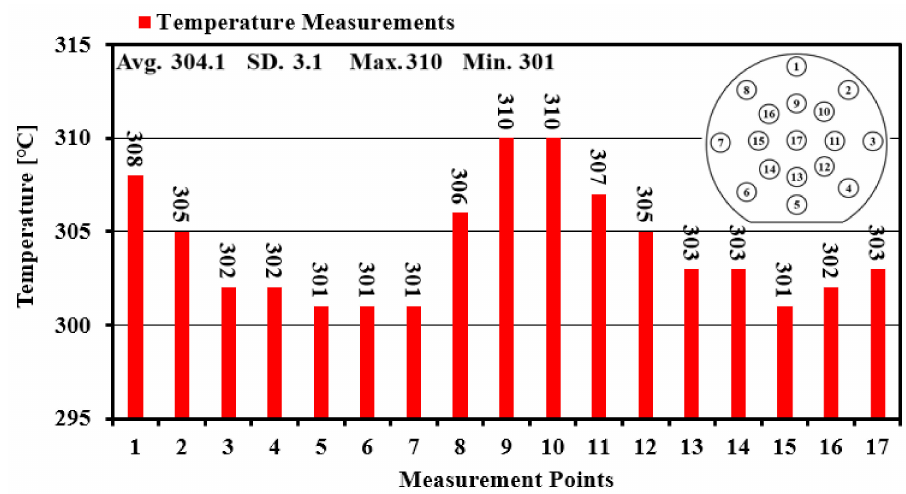
Figure 8. Measured temperature distribution across the wafer.